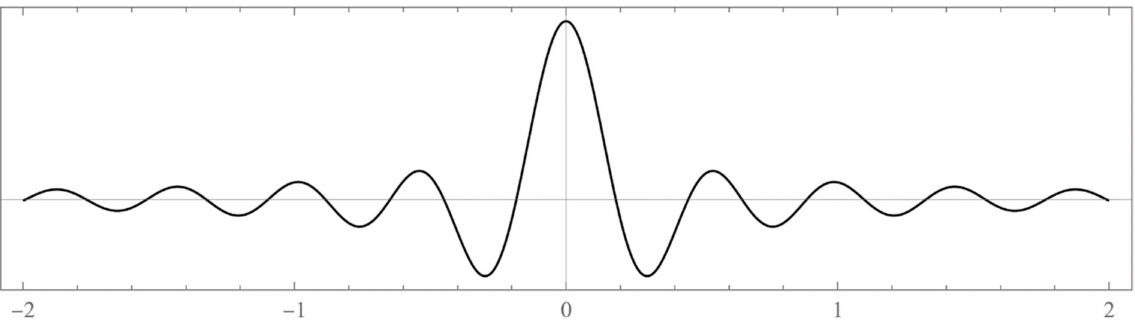
Figure A2. The un-normalized wavefunction (cid:101) ψ ( x , E ) for E = 0 at the middle of the band. The horizontal x -axis is in units of λ − 1 . We took N = 100.